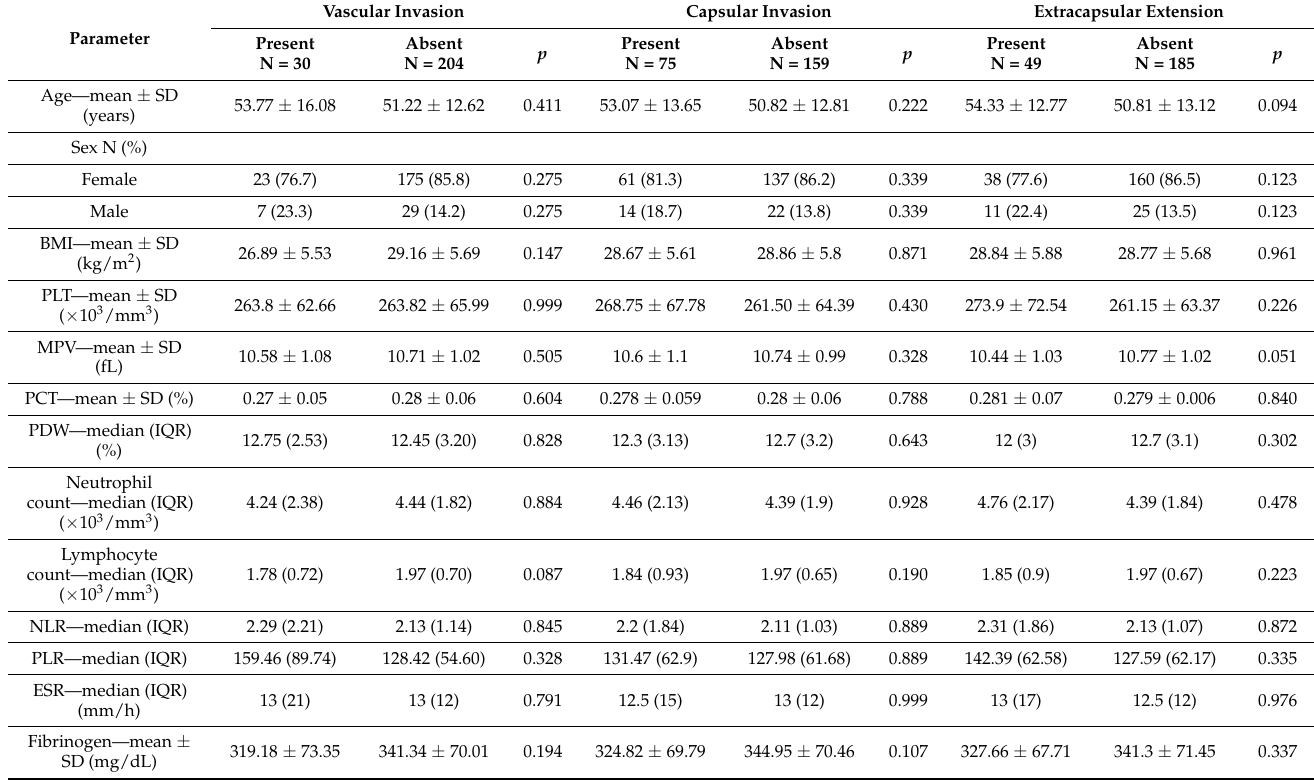
Table 4. Univariate comparative analysis of inflammatory markers and platelet indices according to pathological report characteristics in PTC